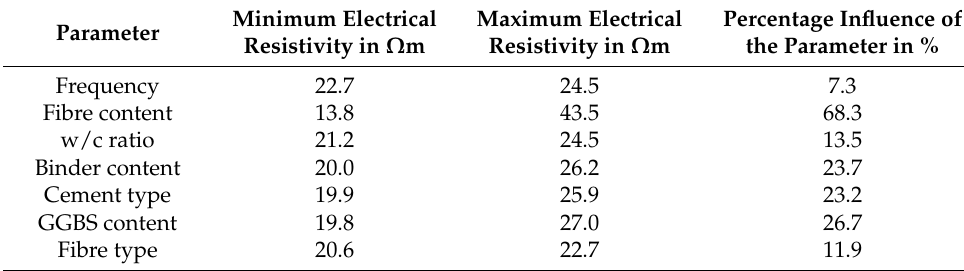
Table 6. Effect of the single parameters on the electrical resistivity of